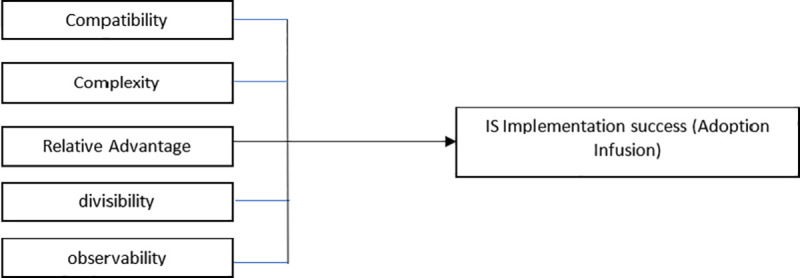
Diffusion of innovation theory by [88].